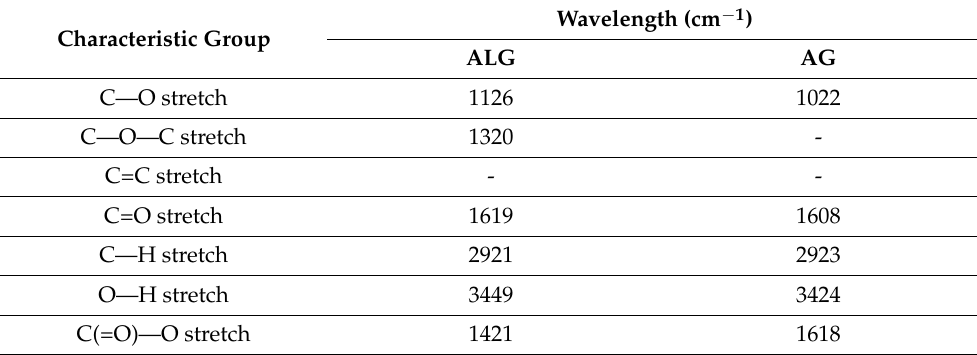
Table 2. Positions of main FTIR stretching bands and their relative assignments for ALG, AG and ALG–AG complex.